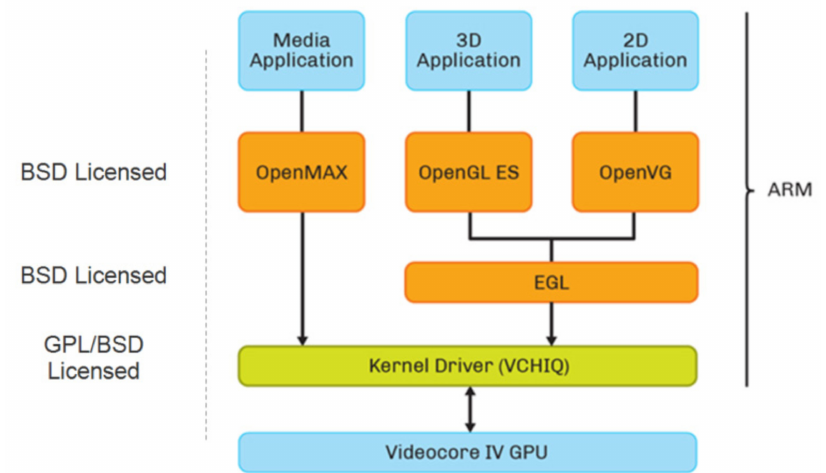
Figure 8. The architecture of the Raspbian OS [23] based on the Berkeley Software Distribution (BSD) Licensing